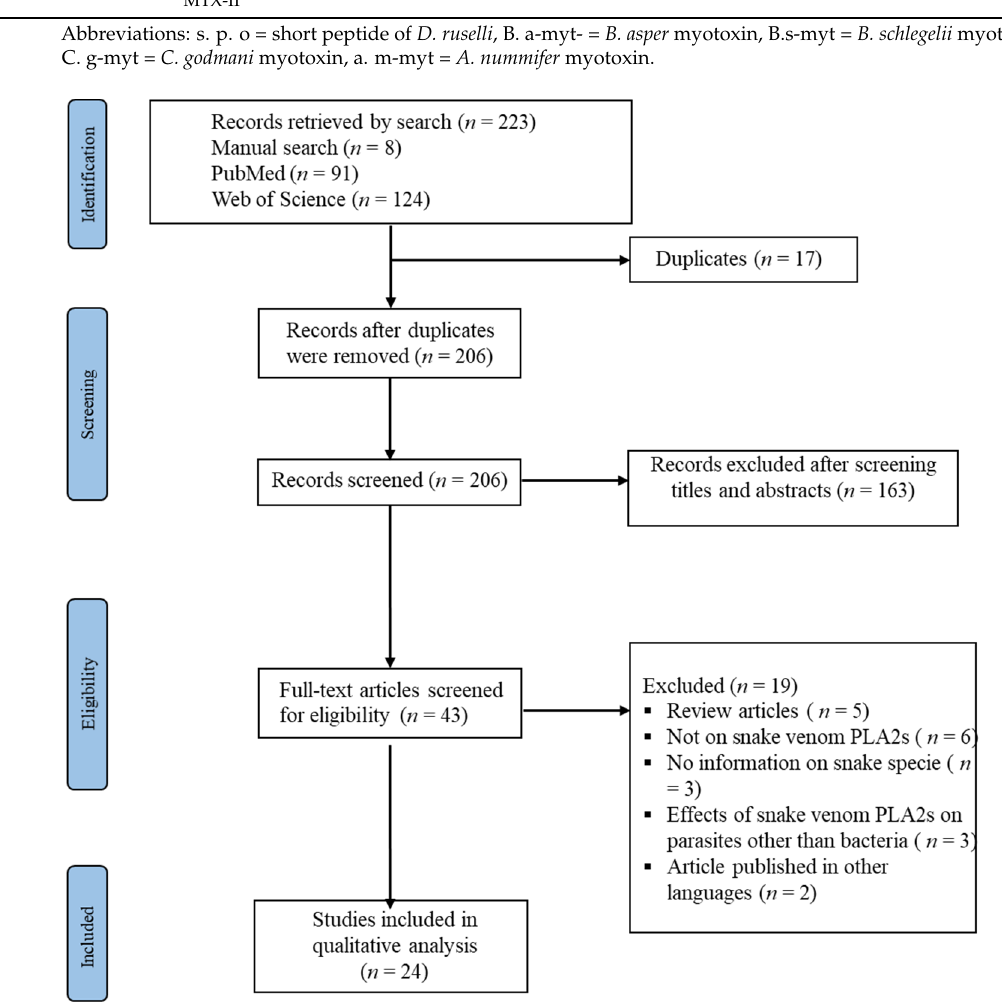
Figure 1. PRISMA diagram for the study search and selection processes. Table 1. Features of the analyzed studies.